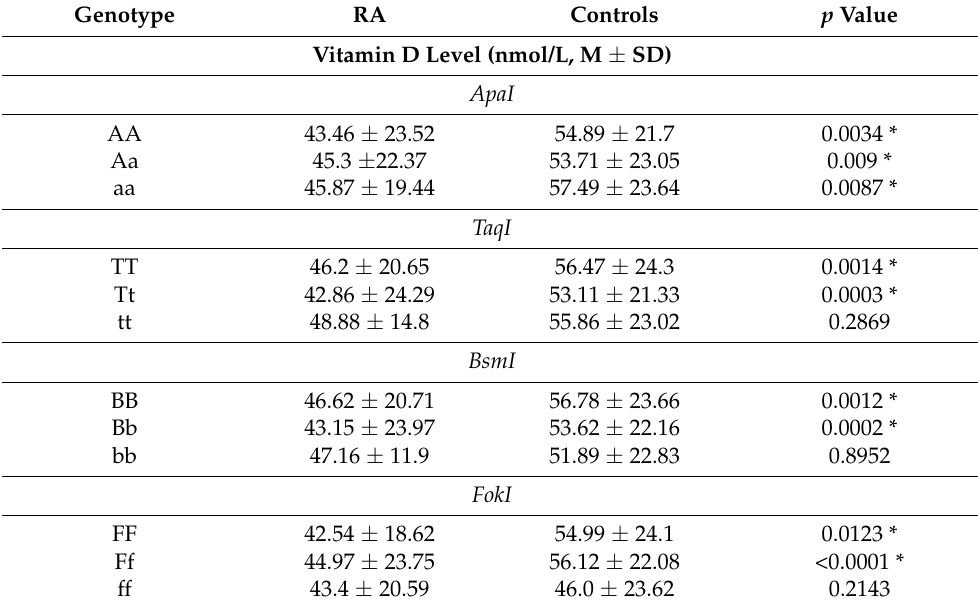
Table 3. Mean vitamin D level in RA and controls grouped by the VDR polymorphism genotypes. Genotype RA Controls